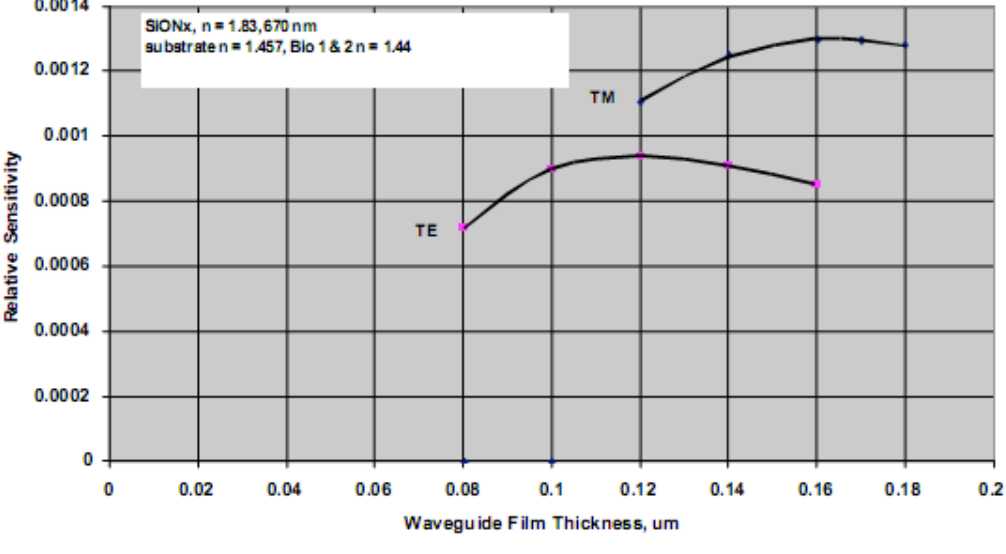
Figure 6. Relative Detection sensitivity for a high contrast waveguide materials